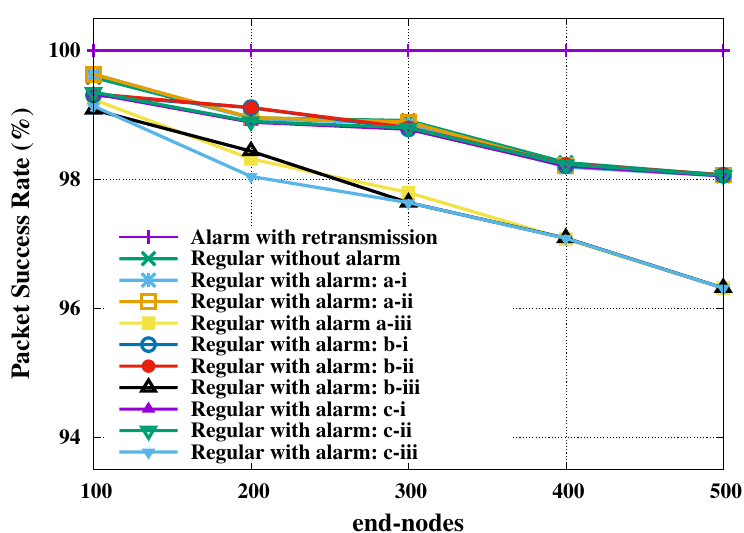
Figure 3. Regular and alarm nodes’ packet success rate for indoor industrial plant. Regarding a 95% confidence level, the largest margins of error, in percentage points, are: 0.000 (alarm with retransmission); 1.186 (regular without alarm); 0.904 (regular with alarm: a-i); 0.905 (regular with alarm: